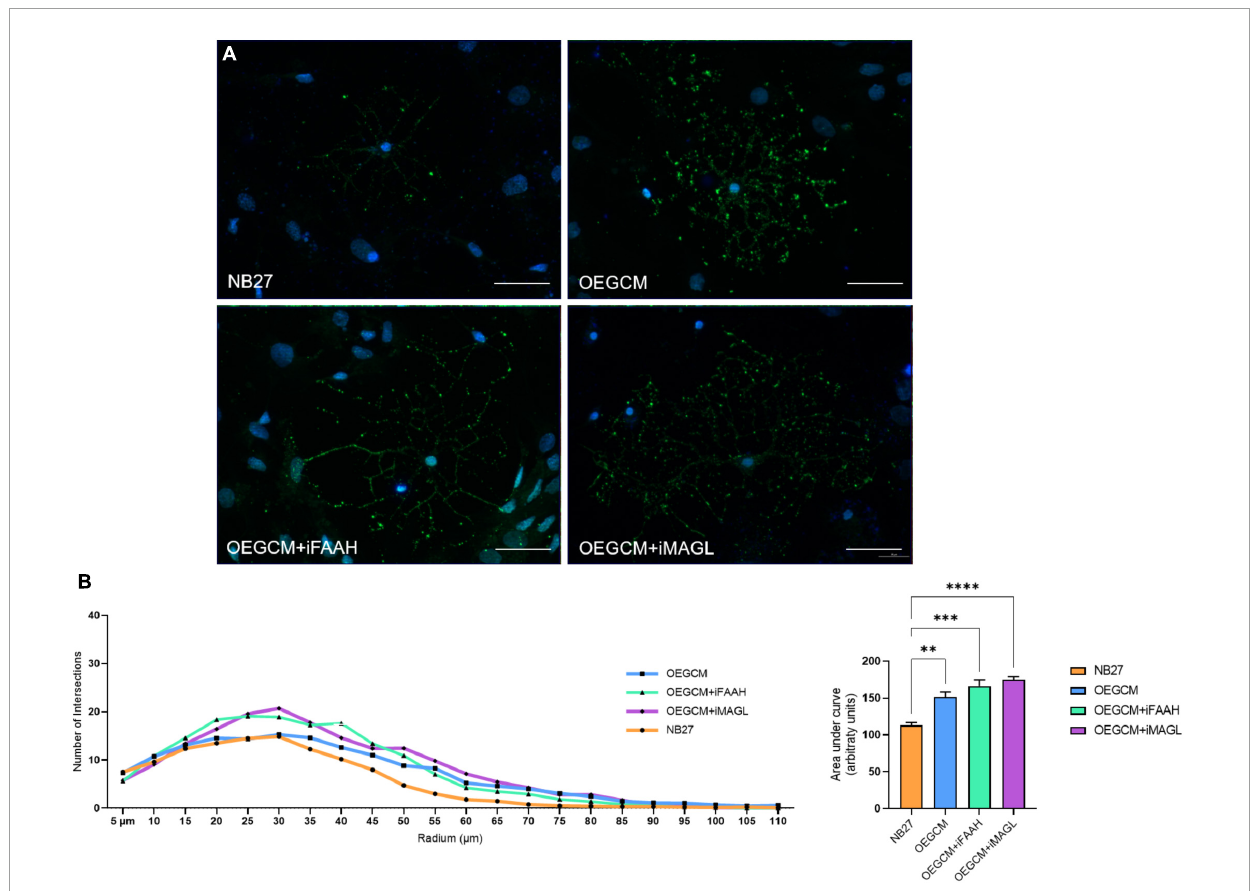
FIGURE8 OEGCM from cultures treated with FAAH or MAGL inhibitors do not exert effects over the complexity of oligodendrocytes process branching assessed by O4 marker. In panel (A) , representative immunocytochemistry of the O4-positive cells in green and cell nuclei in blue (DAPI). Magnification of 40x, scale bar: 20 µ m. In panel (B) , the area under the curve calculates the number of intersections in every 0.5 µ m radium in each Sholl circle. Data is presented as mean ± SD, statistical analysis of AUC was performed using One-way ANOVA and Tukey’s as post hoc test. N = 4 for all experimental conditions, p = 0.0030 for NB27 vs. OEGCM, p = 0.0002 for NB27 vs. OEGCM + iFAAH, p < 0.0001 for NB27 vs. OEGCM + iMAGL, p = 0.3240 for OEGCM vs. OEGCM vs. OEGCM + iFAAH, p = 0.0733 for OEGCM vs. OEGCM + iMAGL. ** p < 0.01, *** p < 0.001, and **** p <